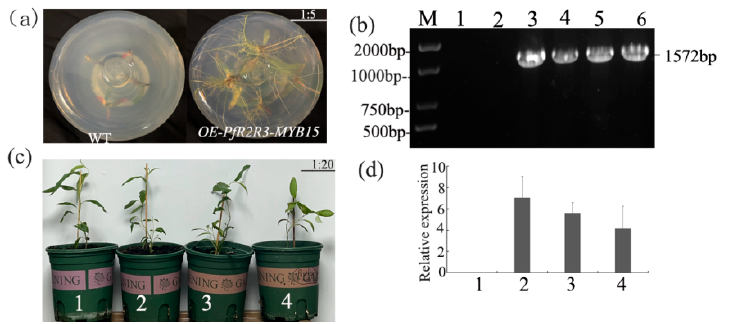
Figure 6. OE-PfR2R3-MYB15 causes witches’ broom symptoms in P. trichocarpa . ( a ) The root morphol- ogy of the WT and the transgenic line. ( b ) PCR detection of OE-PfR2R3-MYB15 . M: DNA marker, 1, WT (negative control); 2, H 2 O (negative control); 3, positive control (plasmid); 4, OE-PfR2R3- MYB15-1 ; 5, OE-PfR2R3-MYB15-2; 6, OE-PfR2R3-MYB15-3 . ( c ) Phenotype identification. 1, WT, 2, OE-PfR2R3-MYB15-1 ; 3, OE-PfR2R3-MYB15-2 ; 4, OE-PfR2R3-MYB15-3 . ( d ) QRT-PCR detection of OE-PfR2R3-MYB15 transgenic plants. 1, WT; 2, OE-PfR2R3-MYB15-1 ; 3, OE-PfR2R3-MYB15-2; 4, OE-PfR2R3-MYB15-3